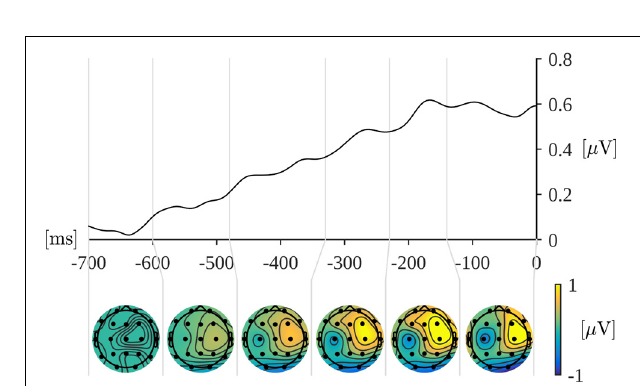
FIGURE 4 | Upper curve: Global field power for the word reading part of the trials. Time 0 is the onset of a word display. Lower plots: Topographical distribution of grand mean amplitudes across participants and conditions within the indicated time windows.